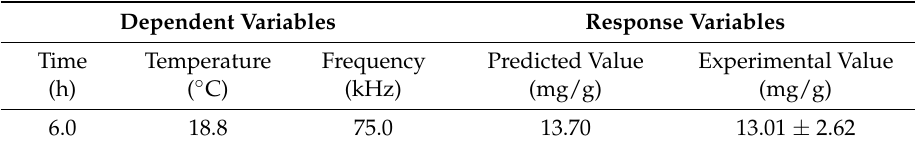
Figure 2. 3-D response surfaces ( a ) and contour plots ( b ) as a function of ultrasonic frequency, process temperature and time. Table 4. Comparison of predicted and experimented values of response variables operated under an optimal extraction